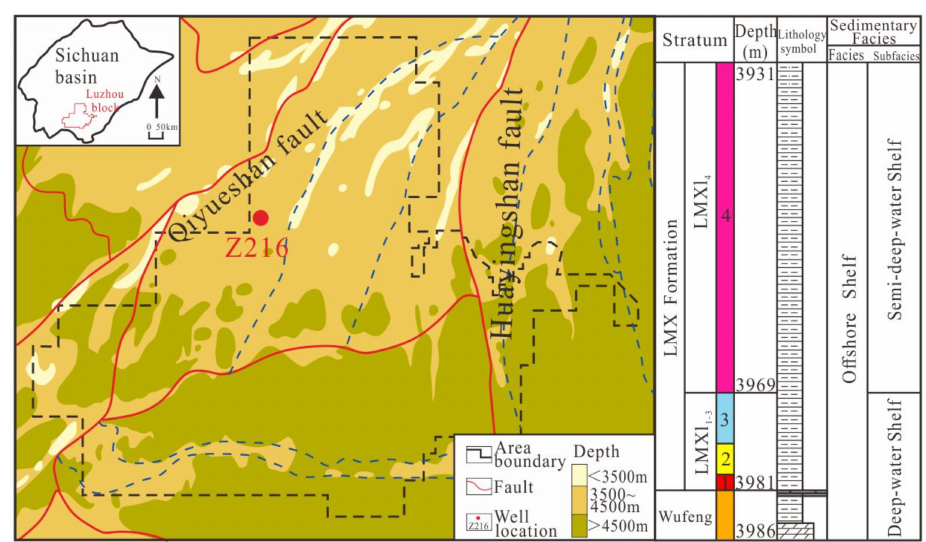
Figure 1. The structural framework of the Luzhou Block and the stratigraphic column of the Upper Ordovician-Lower Silurian strata of the southern Sichuan Basin (modified from